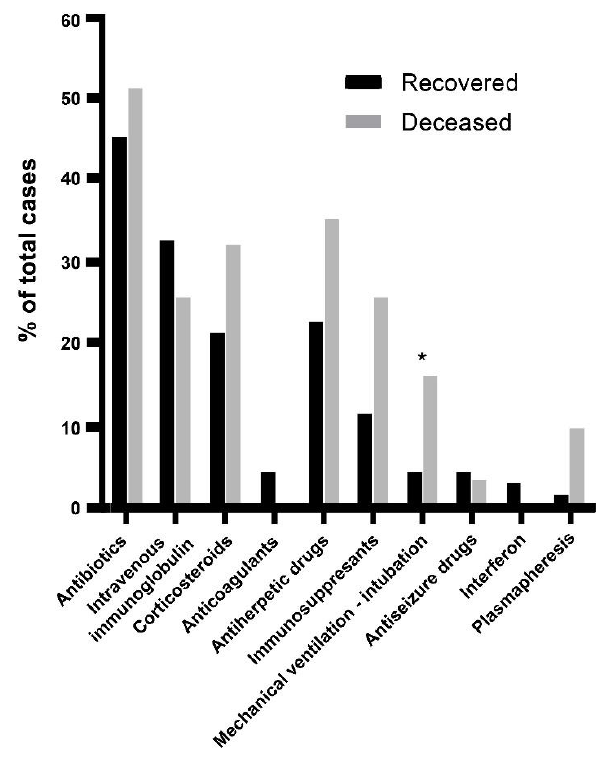
Figure 5. Rates of usage of various treatments and other clinical interventions following hospitalization between patients that recovered and those that deceased. Significant differences for each intervention between the recovered and deceased groups of patients were assessed by a two-tailed t -test (two-sample assuming equal variances) and are indicated by (* p < 0.05).